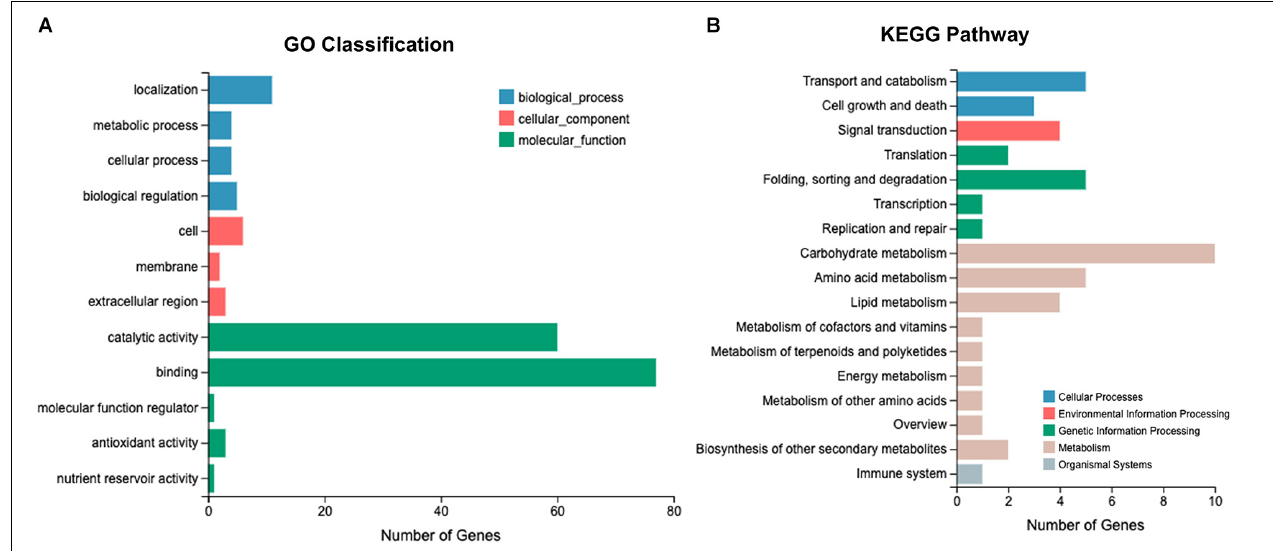
FIGURE 5 | O and KEGG analysis of 1191 DEGs. (A) Genes involved in different GO classifications. (B) Genes involved in different KEGG